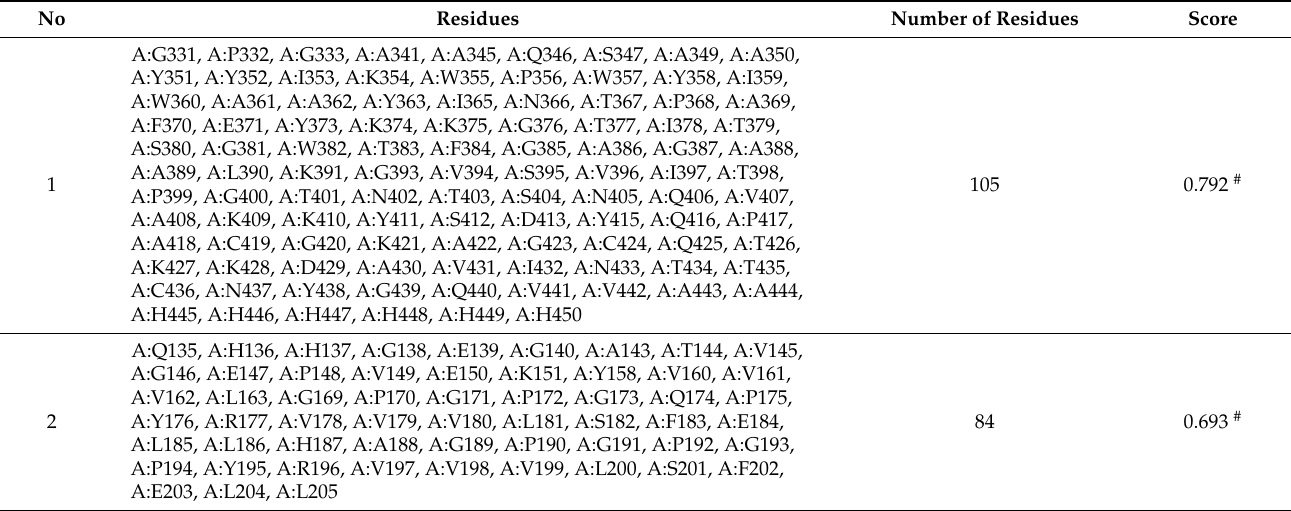
Figure 4. Discontinuous B-cell epitope prediction and molecular docking simulation of the S7D5L4 vaccine. Yellow figures in ( A , B ) represent two discontinuous B-cell epitopes. The rest of the amino acid sequences were shown in gray. ( C ) The model with the lowest complex binding energy was selected for demonstration and subsequent analysis, and the docking results of S7D5L4 and TLR4 were simulated using ClusPro 2.0. Table 3. The discontinuous B cell epitopes residues of the S7D5L4 predicted by the